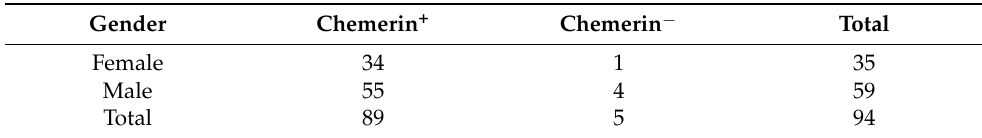
Table 3. Patients and chemerin status by gender. p = 0.413 by Chi-squared test. Evaluated were only patients with readable cores.